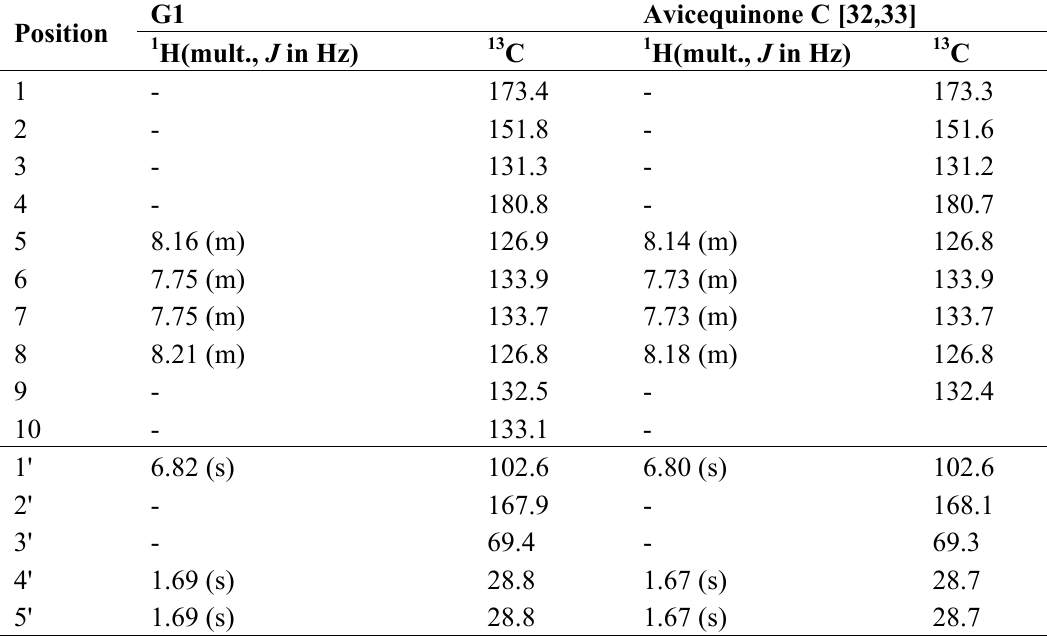
Table 1. NMR spectra data of G1 and avicequinone C in CDCl